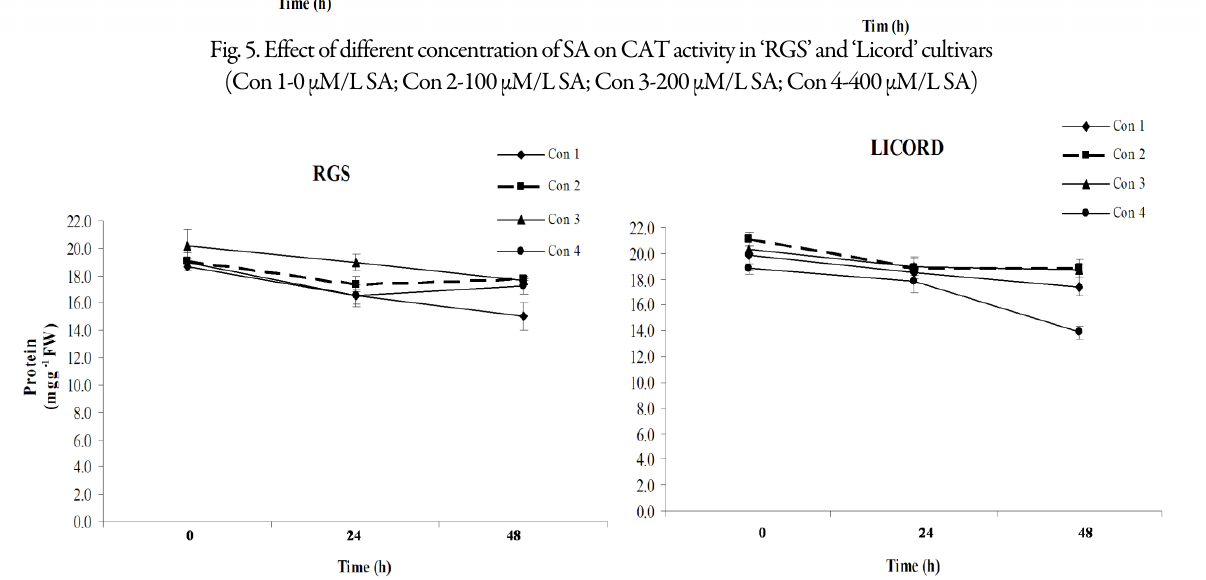
Fig. 6. Effect of different concentration of SA on protein content in ‘RGS’ and ‘Licord’